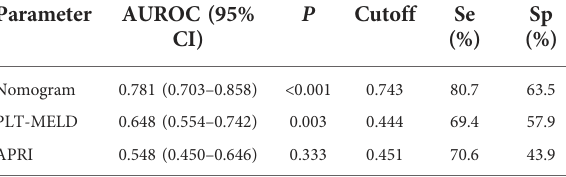
TABLE 3 Predictive performances of nomograms, PLT-MELD and APRI for esophagogastric variceal bleeding with hepatitis B cirrhosis.